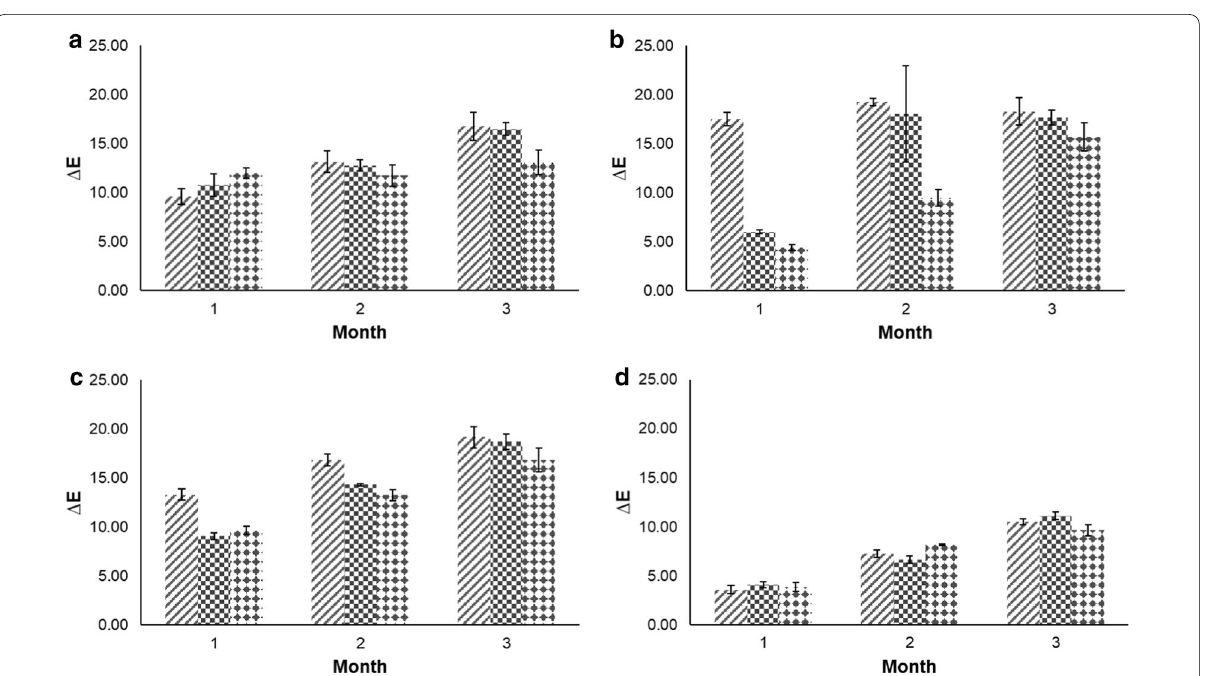
M: mamey, C: carrot, AG: Arabic gum–maltodextrin, MG: Mesquite gum–maltodextrin. Different letters show significant differences ( p < 0.05) between microcapsules within each parameter